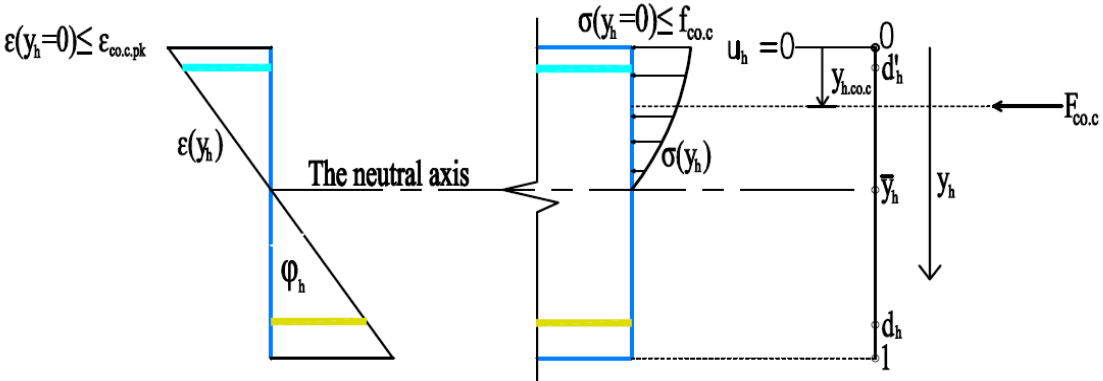
(cid:16) (cid:17) ε ( y = 0 ) ≤ ε co.c.pk